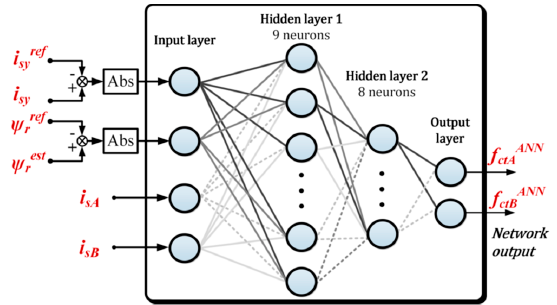
Figure 12. Schematic diagram of designed NN-based detector.